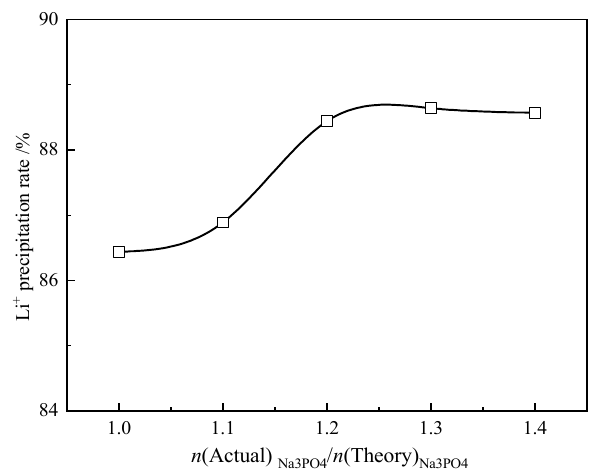
Figure 10. The influence of the molar ratio of the actual dosage and the theoretical dosage of trisodium phosphate on the recovery rate of Li + .